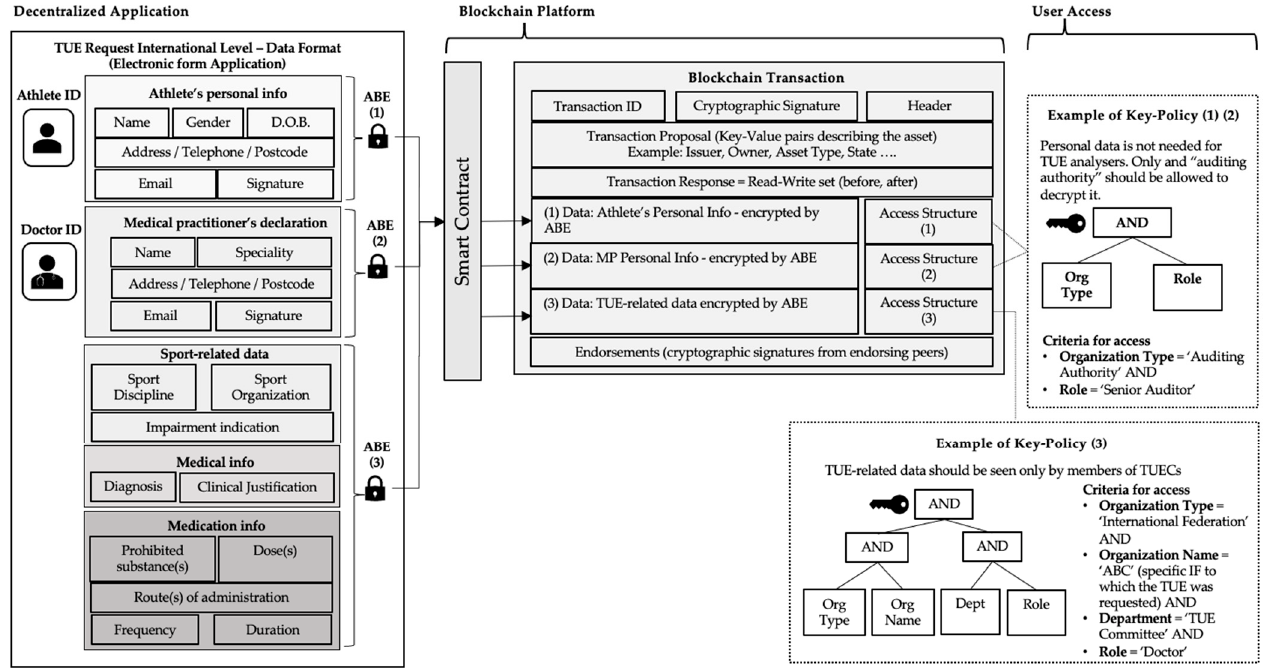
Figure 7. Data format (TUE request)/ transaction structure/examples of ABE policies.